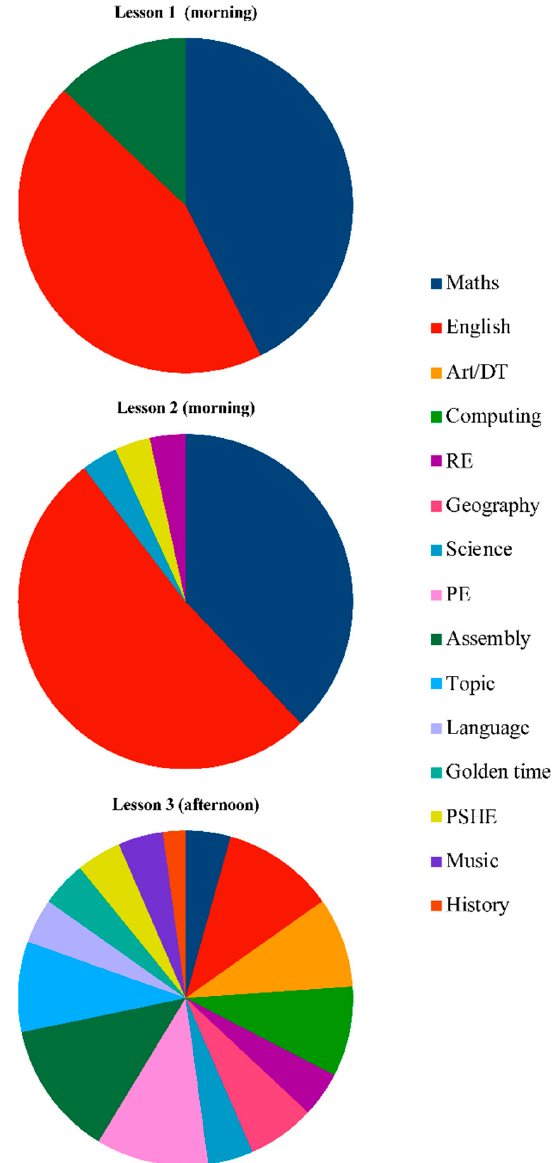
Figure 2. Total frequency of school subjects by lesson segment. (DT: design technology, PE: physical education, PSHE: personal, social, health and economic education, RE: religious education.).